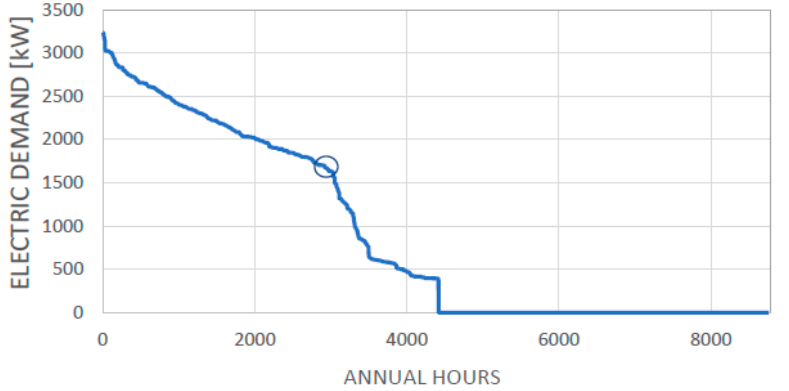
Figure 7. Monotonic electricity demand curve: graphical representation of demand in months with cooling demand.